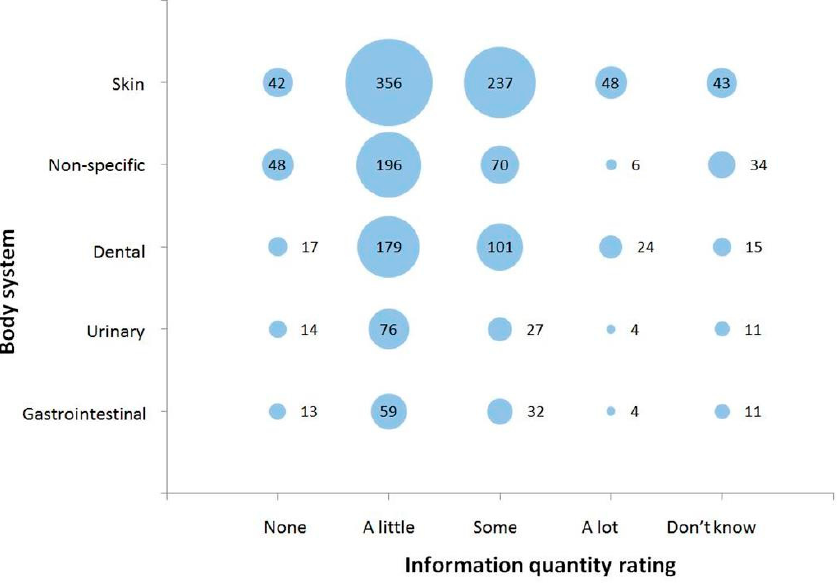
Figure 2. Information quantity rating selected for conditions or complaints affecting the five most commonly categorised body systems in guinea pigs ( n = 1925) from a survey of UK veterinarians. Size of the bubble, and the data label within or to the right of each bubble, corresponds to the total number of conditions or complaints fitting into each combination of body system category and information quantity rating.